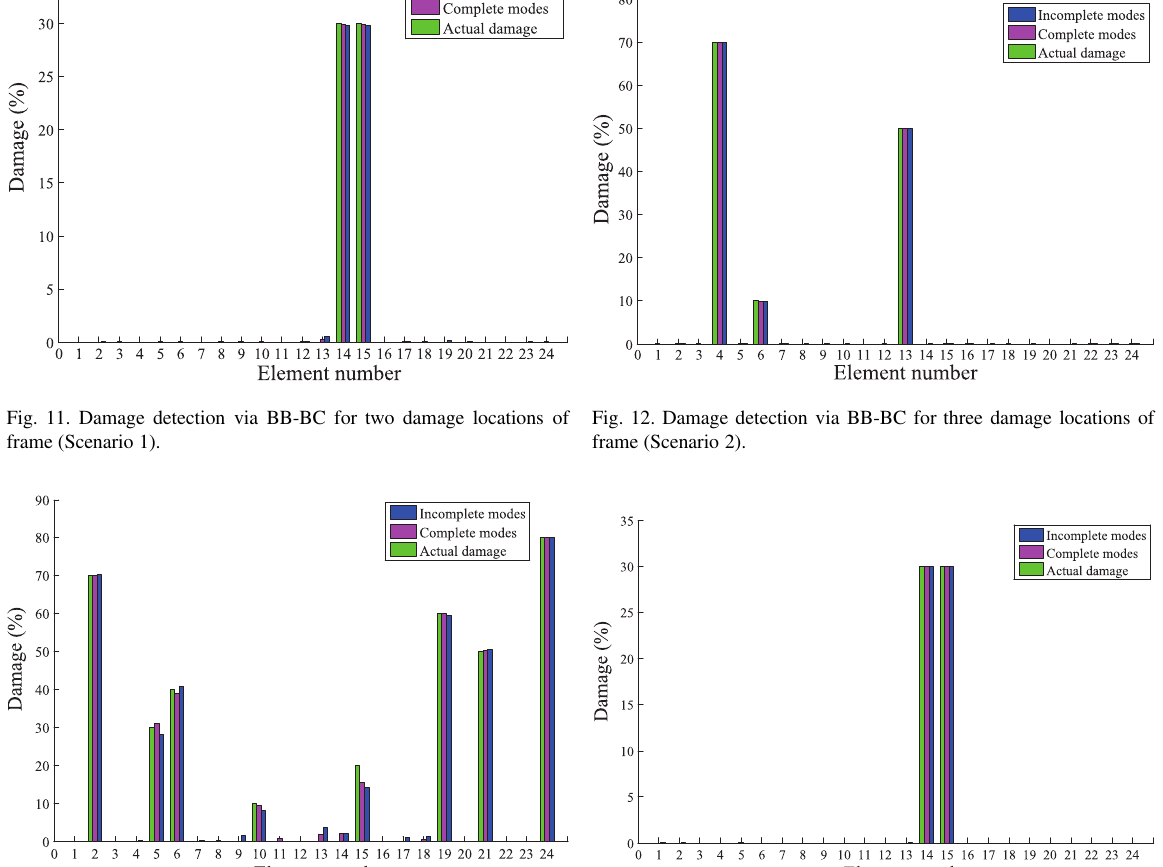
Fig. 14. Damage detection via PSOPC for two damage locations of frame (Scenario